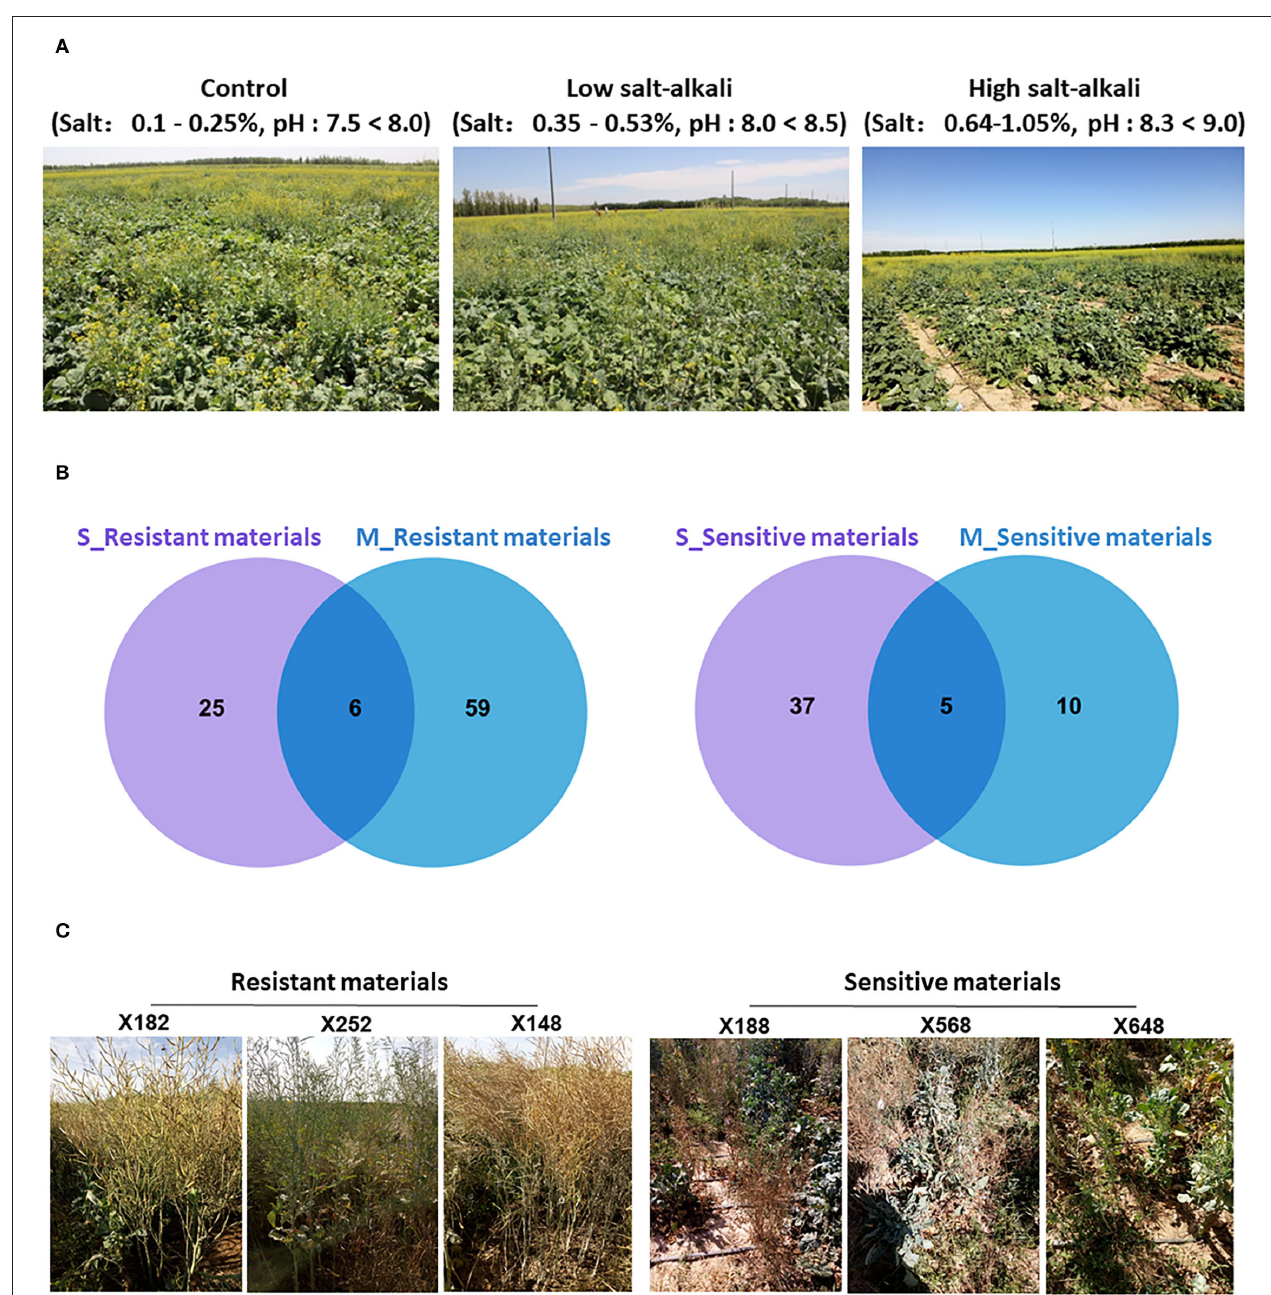
FIGURE 1 | The plant growth stage of 505 B. napus accessions and screening results of extreme materials under salt-alkali stress conditions at seedling and mature stages. (A) Growth state of 505 B. napus accessions under control, low salt-alkali, and high salt-alkali conditions. (B) Venn diagrams showing resistant and sensitive materials under the salt-alkali condition at seedling and mature stages. (C) The response of extreme materials to salt-alkali stress at the mature stage in Inner Mongolia Autonomous Region of China.